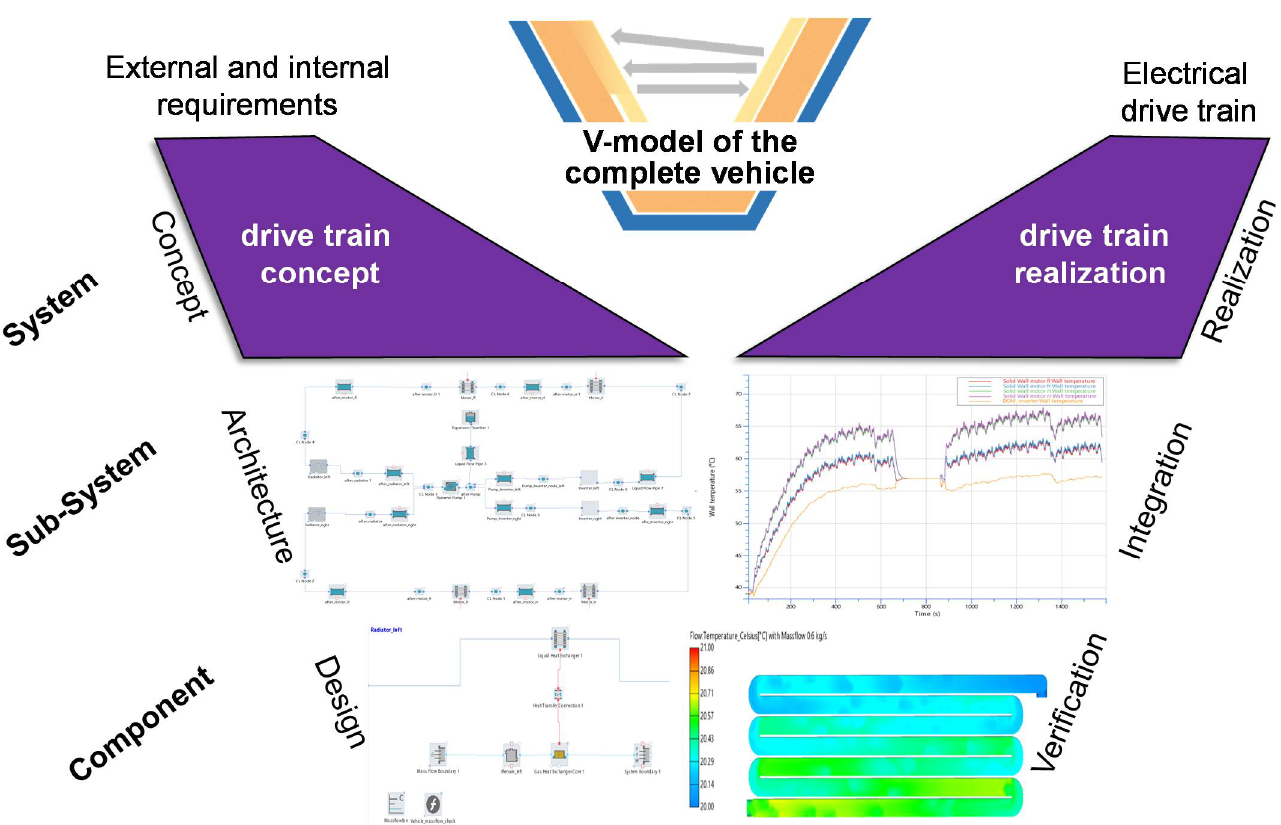
Figure 6. Realization of all levels of the V-model by using the simulation tools of the AVL eSUITE™ for the thermal system.